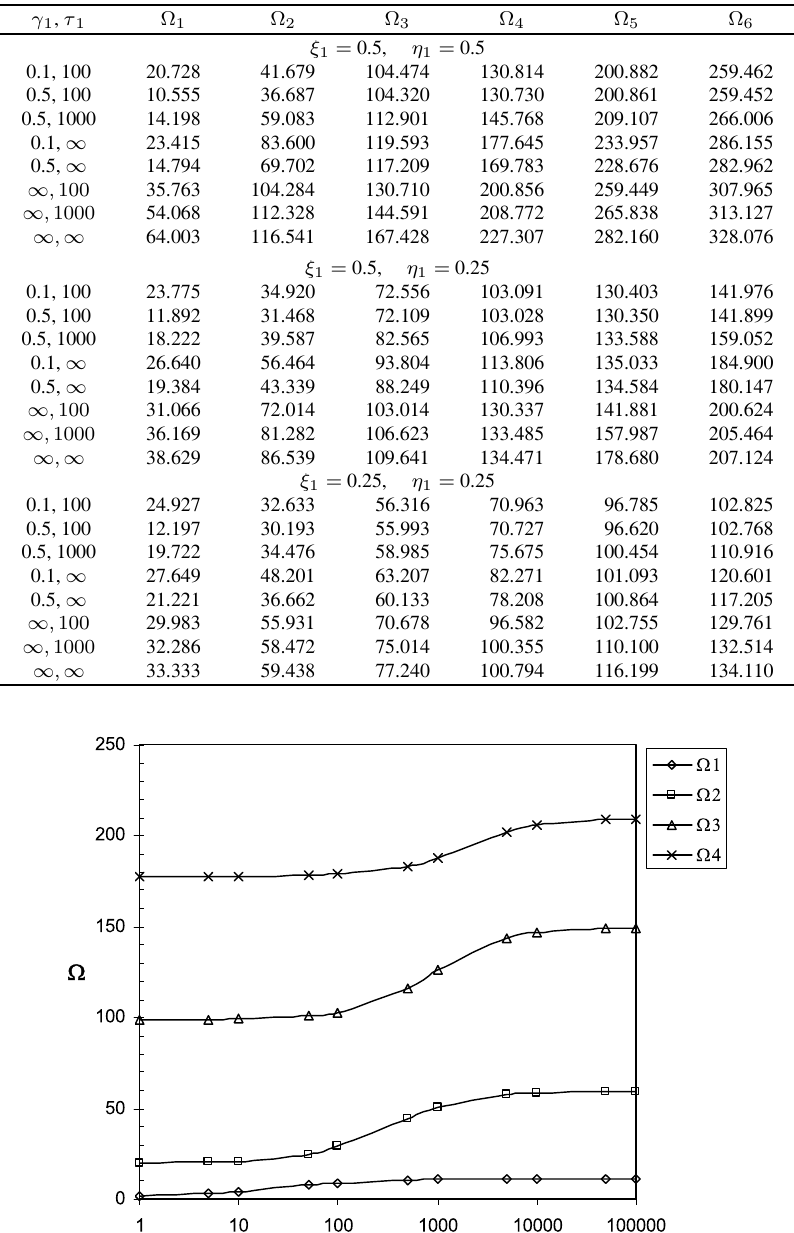
Table 4 The fi rst six eigenfrequencies of coupled vibration for a SCSC square plate with one sprung mass